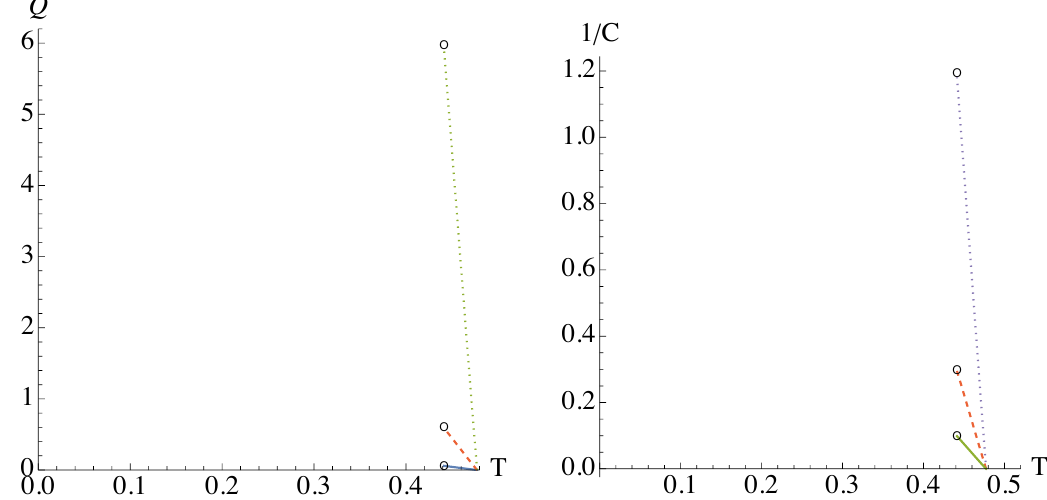
˜ Q, V , C ) ensemble. Left : Low-entropy and and T = T . Right : A similar crit crit